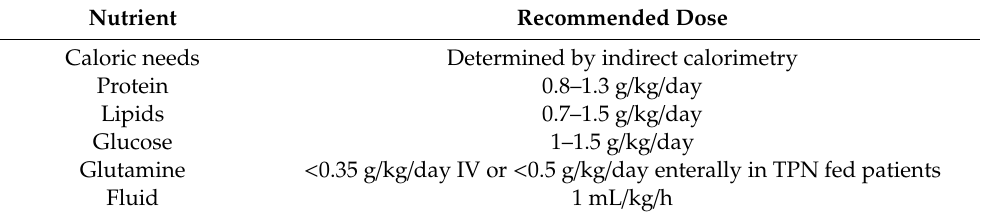
Table 1. Nutritional recommendations in